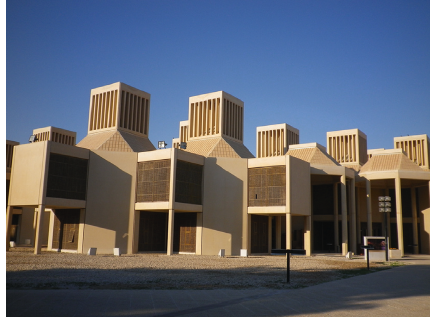
Figure 1: The case study: the Male Engineering Building at Qatar